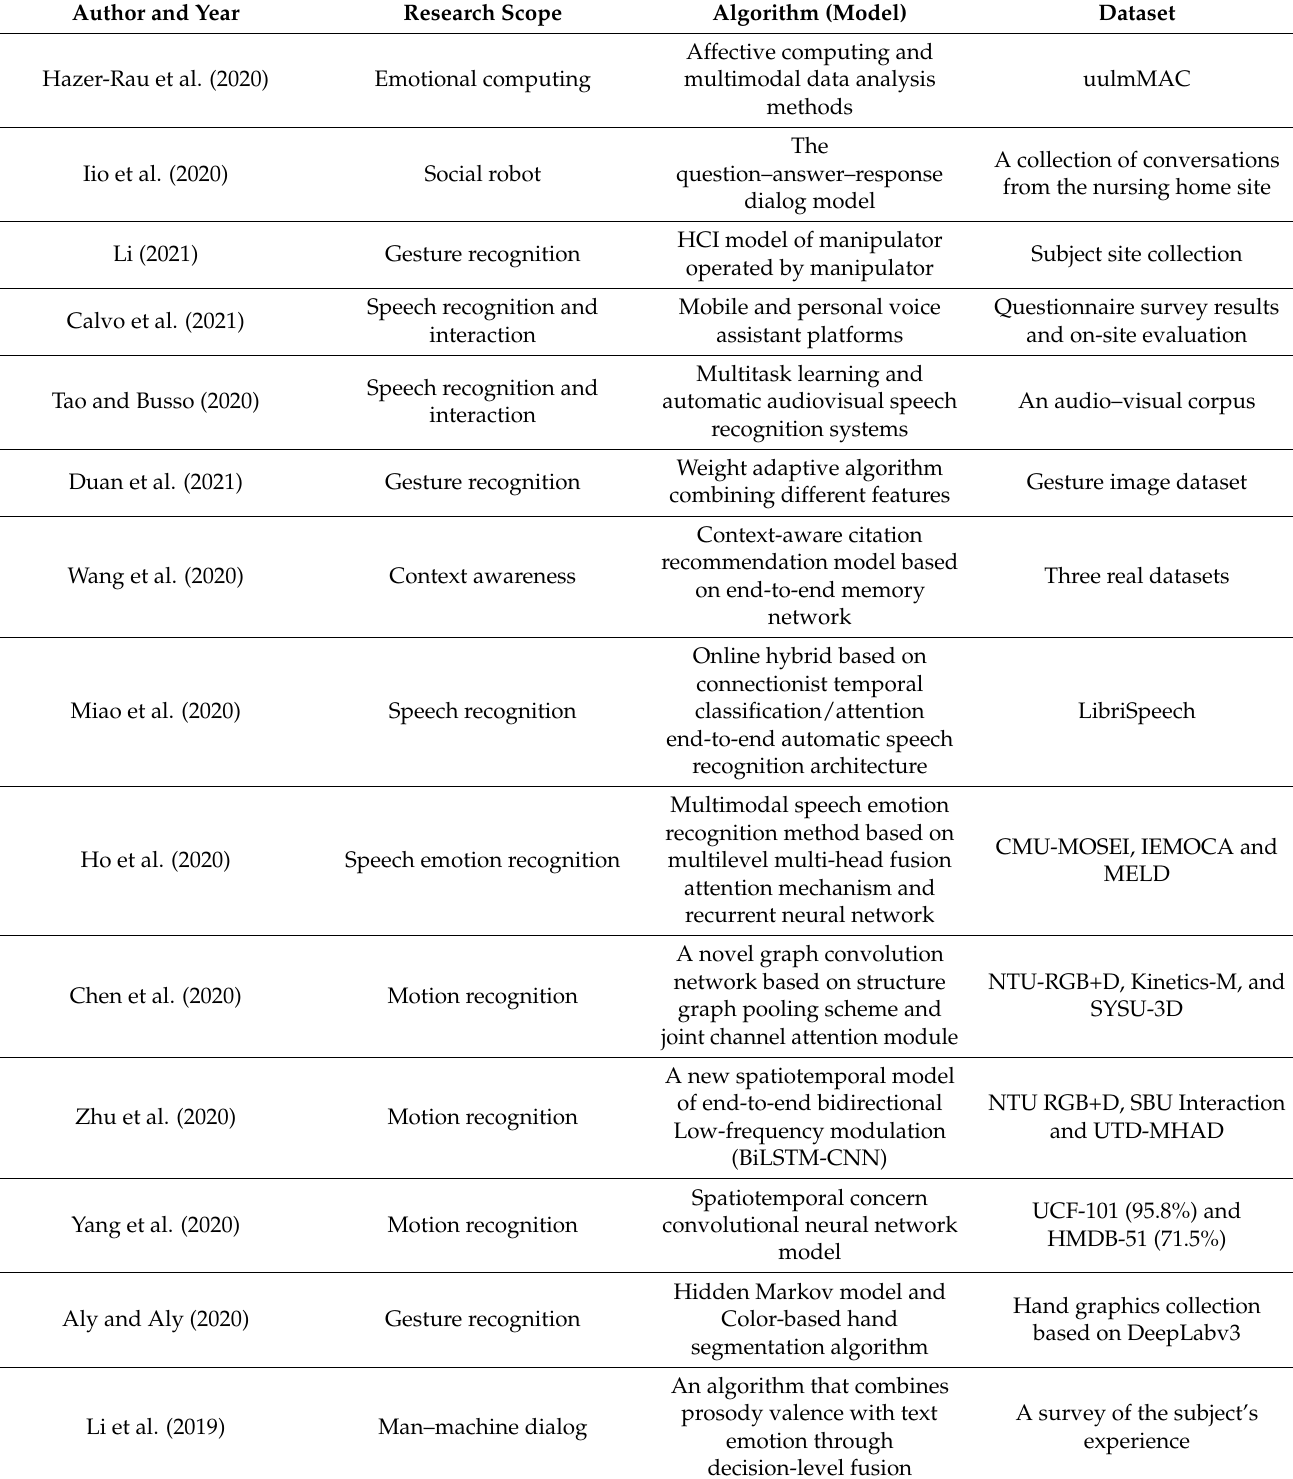
Table 4. Summary of algorithms and datasets used by deep learning technology in intelligent HCI